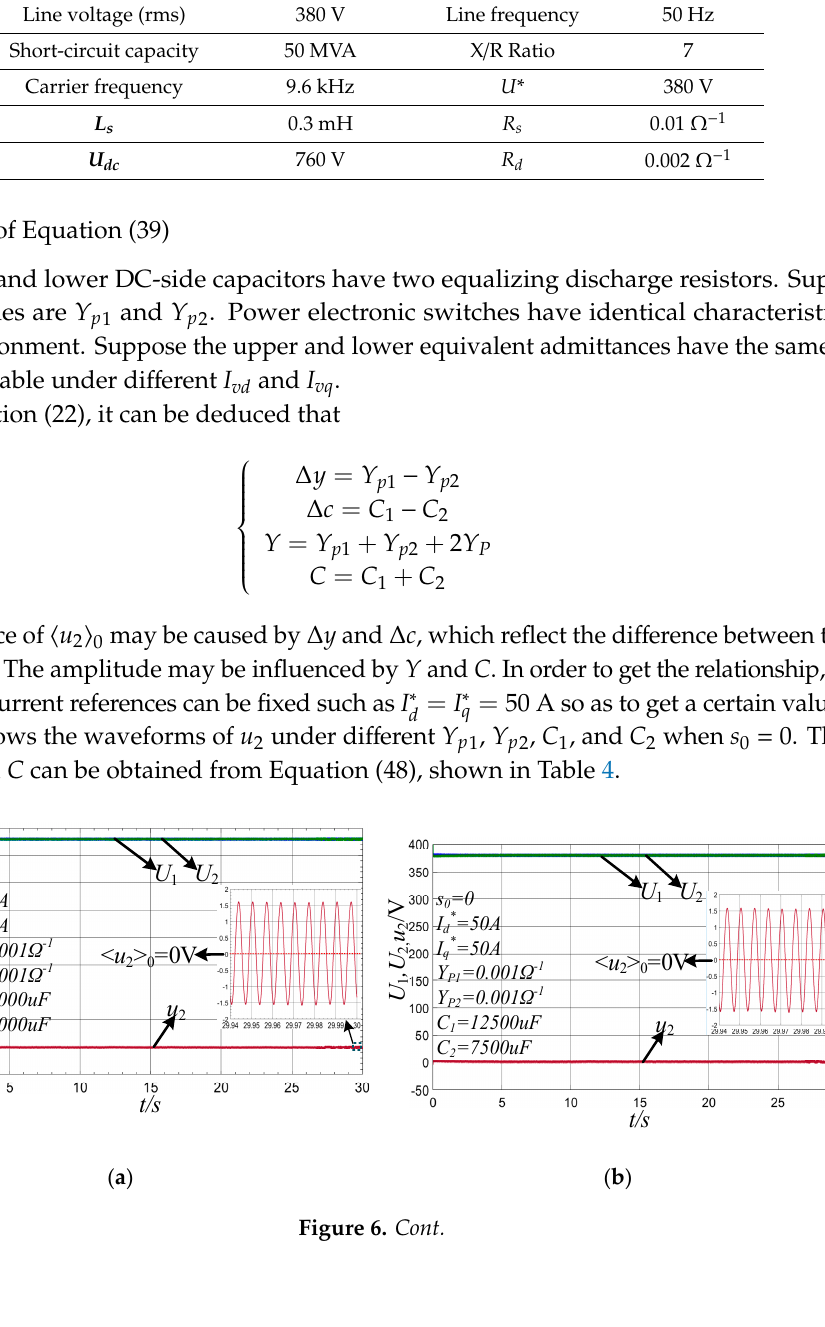
Figure 5. The control block of simulation model. Table 3. The basic simulation parameters.